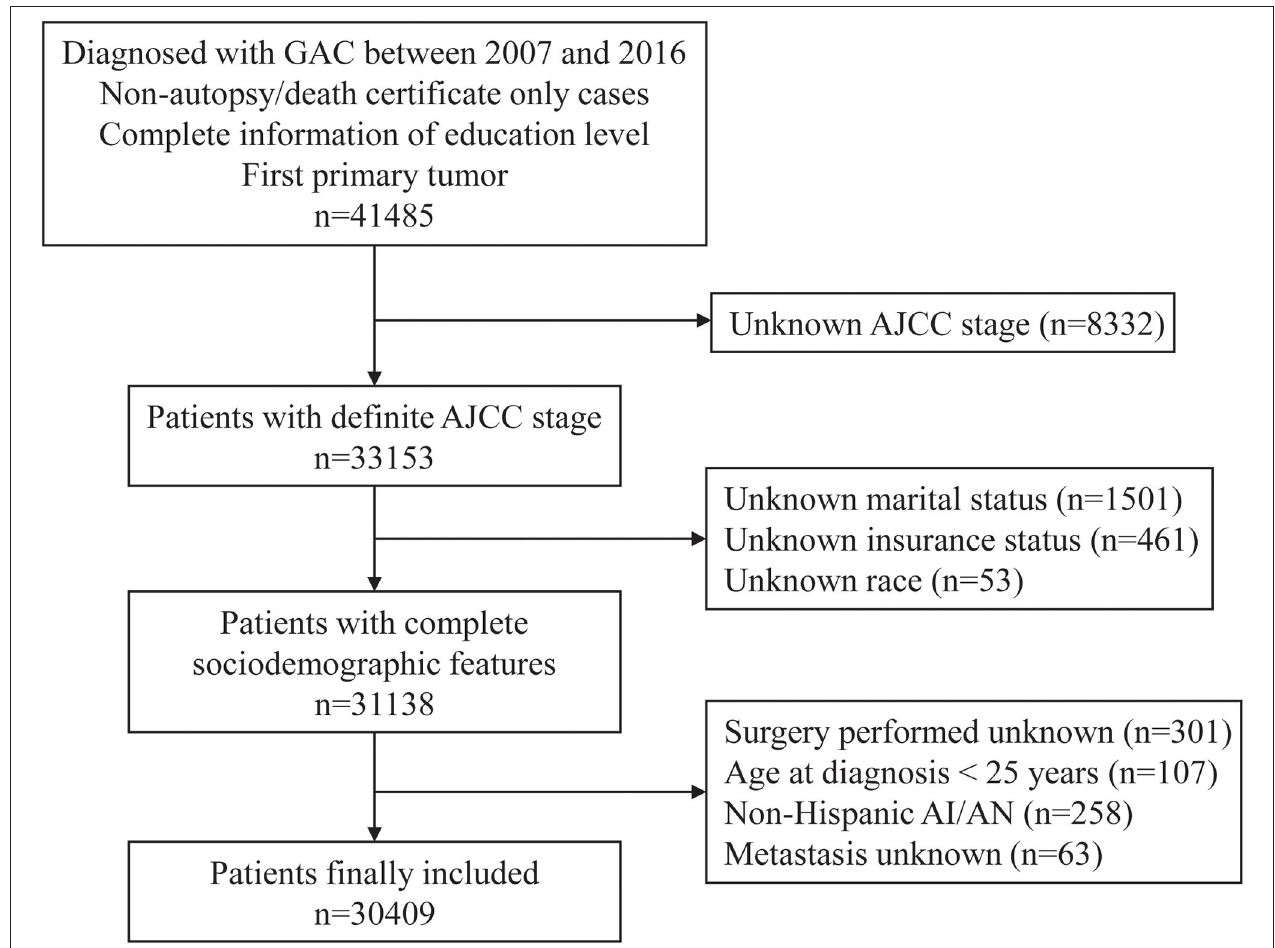
FIGURE 1 | The flowchart for screening patients in the SEER database. GAC, gastric adenocarcinoma; AJCC, American Joint Committee on Cancer; AI/AN, American Indian/Alaska